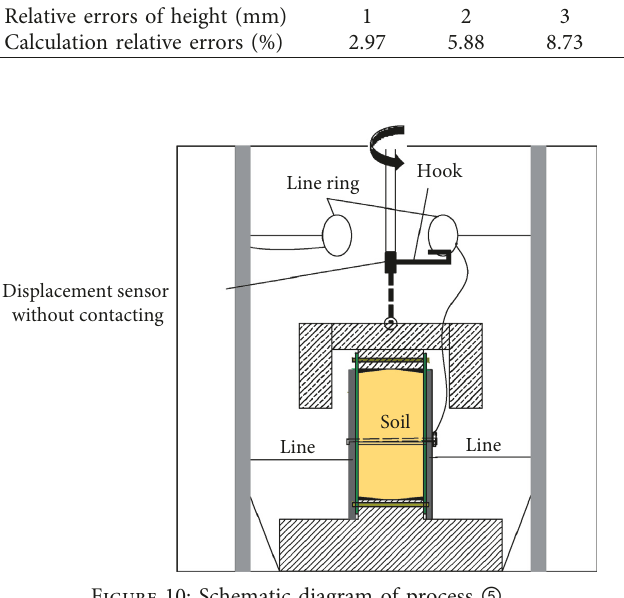
Figure 10: Schematic diagram of process ⑤ .